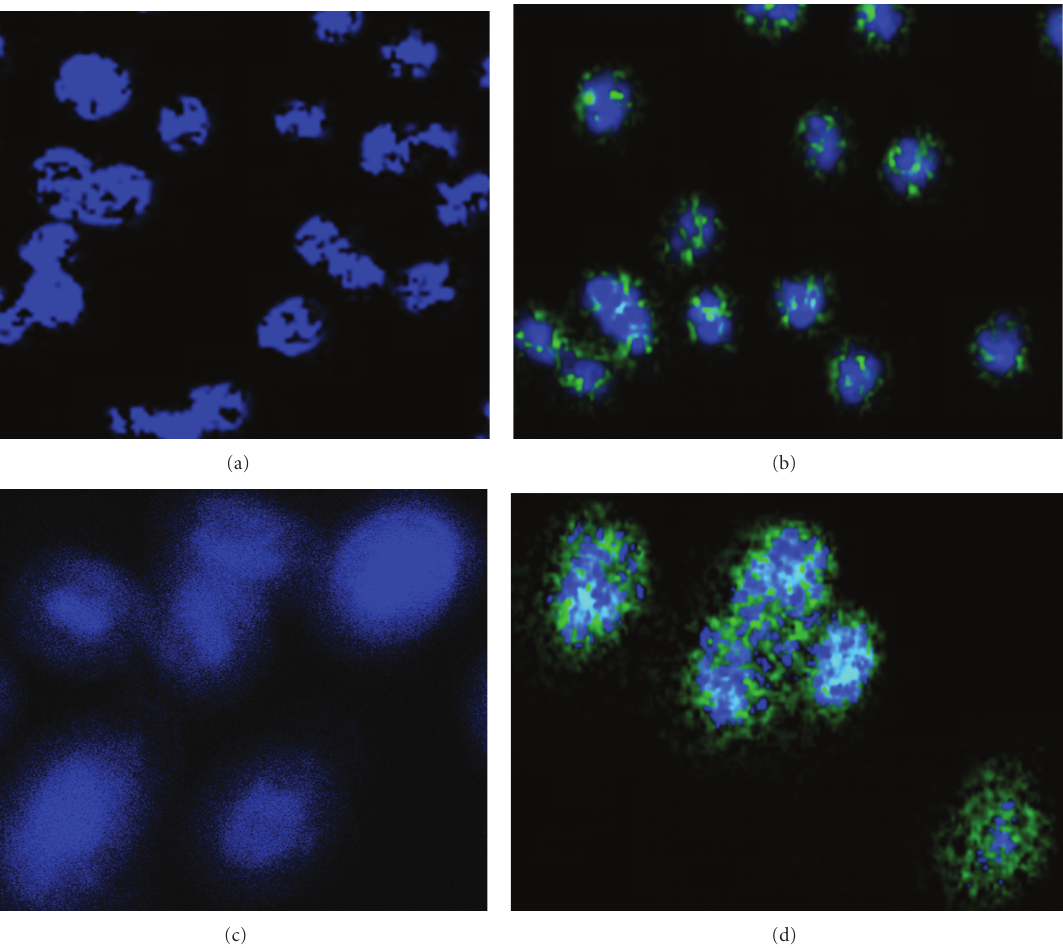
Figure 1: Photomicrographs showing infectivity of cells with C. trachomatis . Mouse J774 macrophages (a and b) and HeLa (c and d) (2.5 × 10 4 cells/well) were infected with C. trachomatis EBs (2.5 × 10 3 IFU/well) and incubated for 2 days at 37 ◦ C and 5% CO 2 . Harvested cells were stained with a monoclonal antibody to C. trachomatis and an FITC-labeled secondary antibody (green) and the nuclei counterstained with DAPI (blue). Chlamydia was visualized by confocal fluorescence